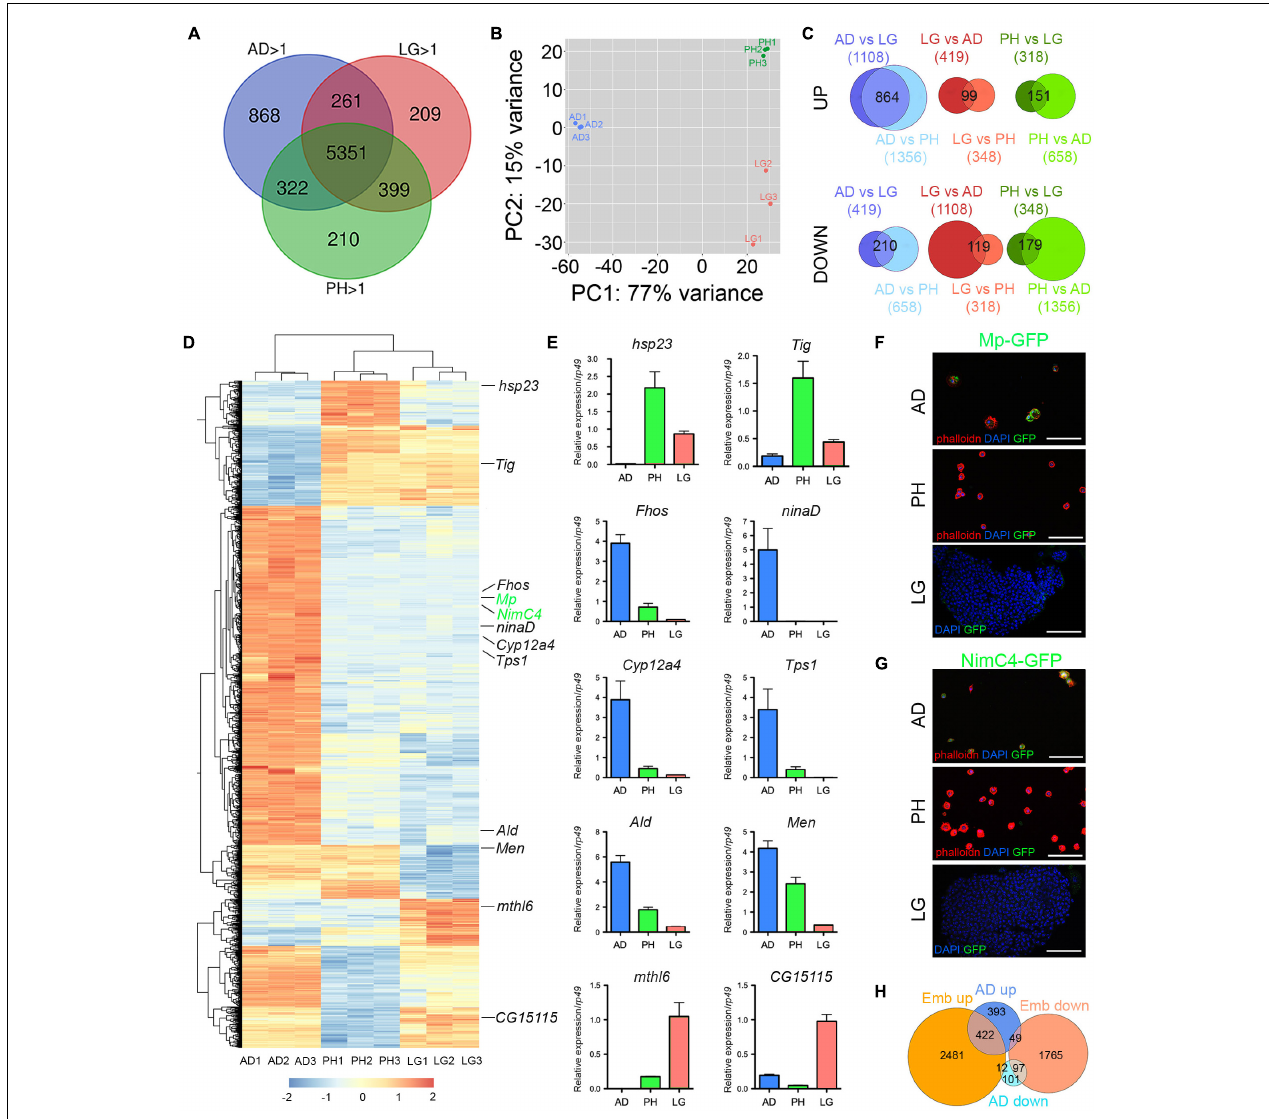
FIGURE 2 | Analysis of adult blood cell gene expression profile. (A) Venn diagrams showing the number of genes expressed (RPKM > 1 in all three biological replicates) in adult hemocytes (AD), larval peripheral hemocytes (PH) and larval lymph glands (LG) as determined by RNA-seq on w 1118 females. (B) Principal component analysis of the RNA-seq profiles of adult, peripheral and lymph gland biological triplicates. (C) Venn diagrams showing the overlaps between differentially expressed genes in pairwise comparisons (adjusted p -value < 0.01 and fold change > 2). Upper panels: up-regulated genes. Lower panels: down-regulated genes. The number of up- or down-regulated genes in each condition is indicated in brackets and the number of genes commonly deregulated is indicated in the Venn diagram intersection. (D) Heat map of the genes differentially expressed between adult versus larval hemocytes. The genes tested in panels E to G are indicated. (E) The expression level of the indicated genes was determined by RT-qPCR on adult hemocytes, larval peripheral hemocytes and larval lymph glands. Expression levels were normalized to rp49 . Means and SEM from three independent experiments are represented. (F,G) Confocal images showing GFP expression in adult and larval hemocytes from Mp-GFP (F) or NimC4-GFP (G) reporter lines. Nuclei were stained with DAPI (blue). For adult and larval peripheral hemocytes (upper and middle panels), the samples were stained with phalloidin (red). Lower panels show a lymph gland anterior lobe. Scale bar: 50 µ m. (H) Venn diagrams showing the overlaps of up- or down-regulated genes between adult versus larval hemocytes (AD, blue) or embryonic versus larval hemocytes (Emb,